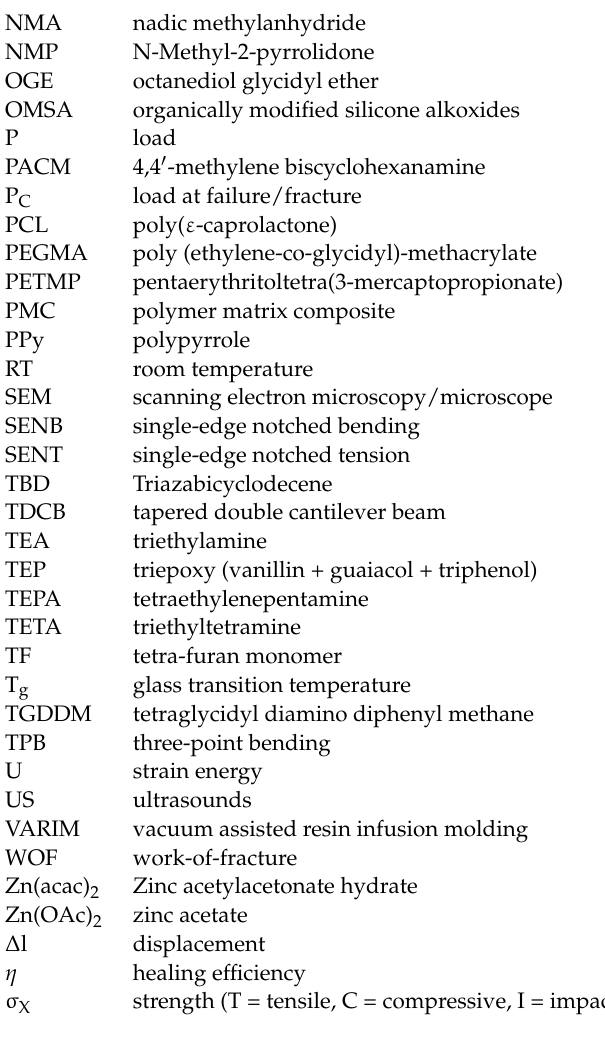
strength (T = tensile, C = compressive, I = impact, F =